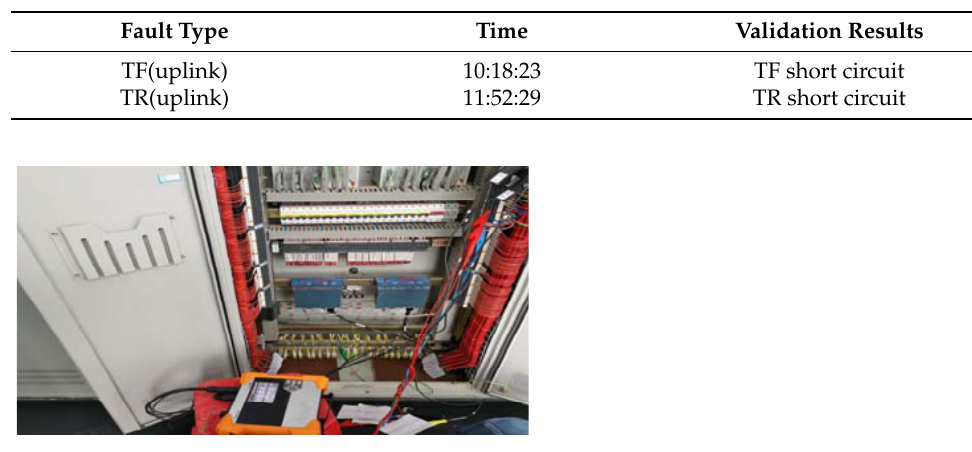
Figure 19. PQ ‐ Box 200 Power quality analyzer in field experiments. Figure 19. PQ-Box 200 Power quality analyzer in field